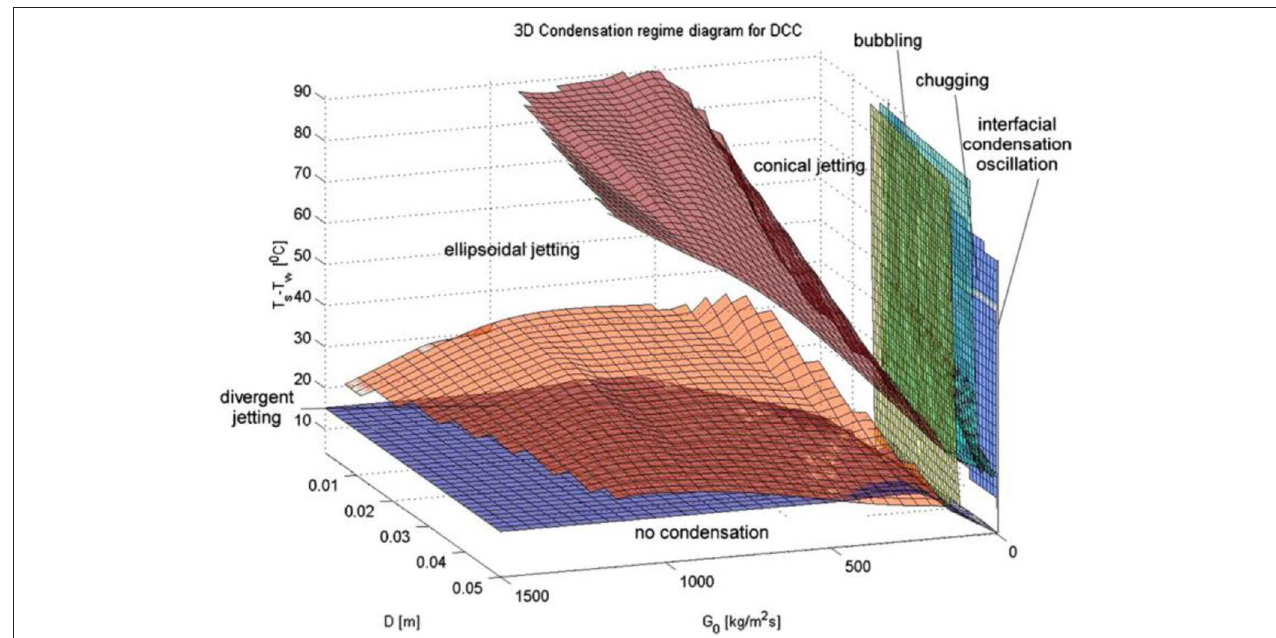
FIGURE 6 | The regime map developed by Petrovic De With et al. (2007).